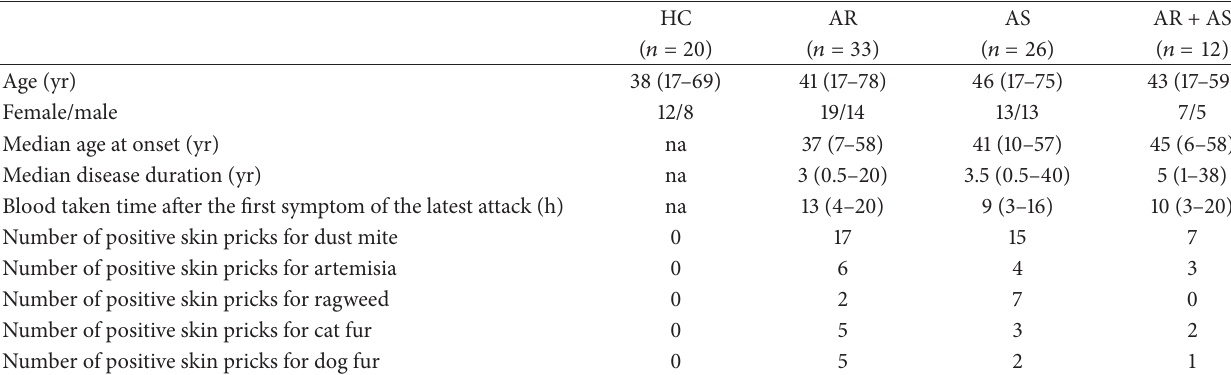
Table 1: General characteristics of the patients with rhinitis (AR), asthma (AS), and combined rhinitis with asthma (AR + AS) or healthy control subjects